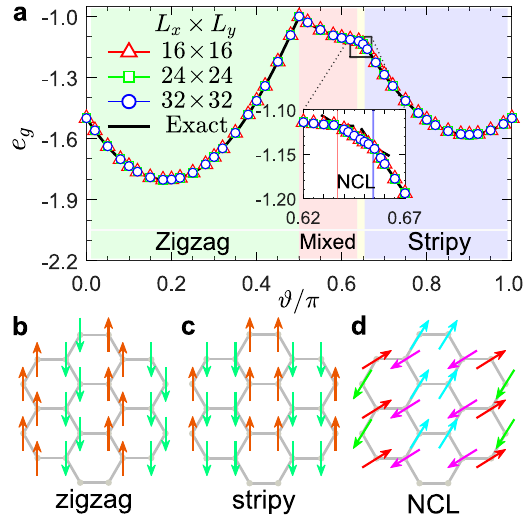
Fig. 2 Classical phase diagram. a Monte Carlo simulations of classical energy e g under three XC clusters of 16 × 16 (red triangle), 24 × 24 (green square), and 32 × 32 (blue circle). The solid black line stands for the exact solution given by the energy optimization method. The classical phase diagram is then determined by kinks in = π (cid:7) 0 : 6476 . energy curves. Inset: Zoom in of energy curves near ϑ cl t ; r A noncollinear (NCL) phase appears in a narrow window of 0.6368 < ϑ / π < 0.6543. b , c Depict the zigzag order and stripy order, respectively. d A NCL phase with a unit cell of 4 ×